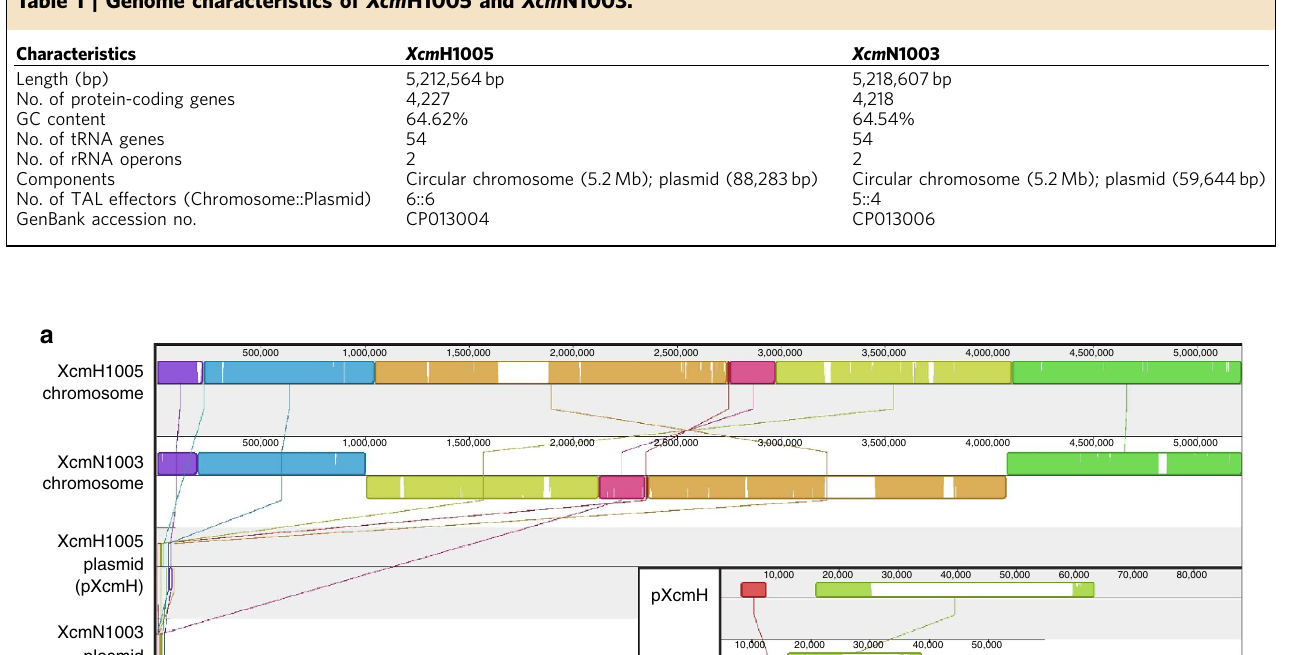
Table 1 | Genome characteristics of Xcm H1005 and Xcm N1003.